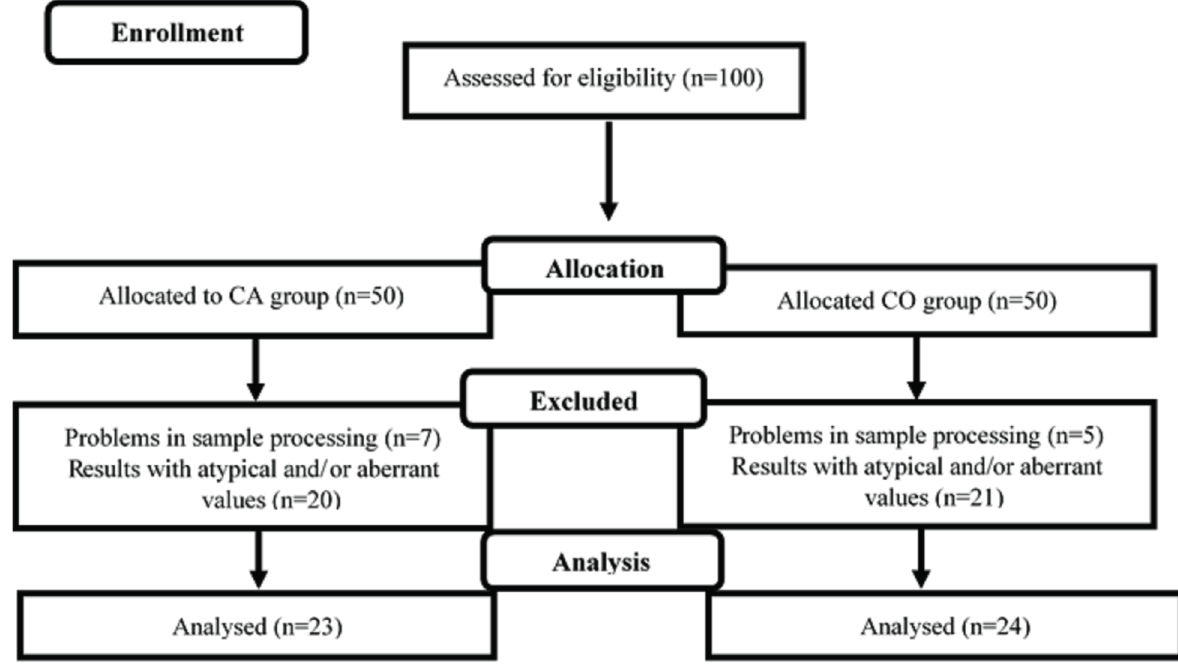
Figure 1 - Flow chart – final study sample to carry out the comet test. n = sample number; CA = group of cases with lung cancer; CO = control